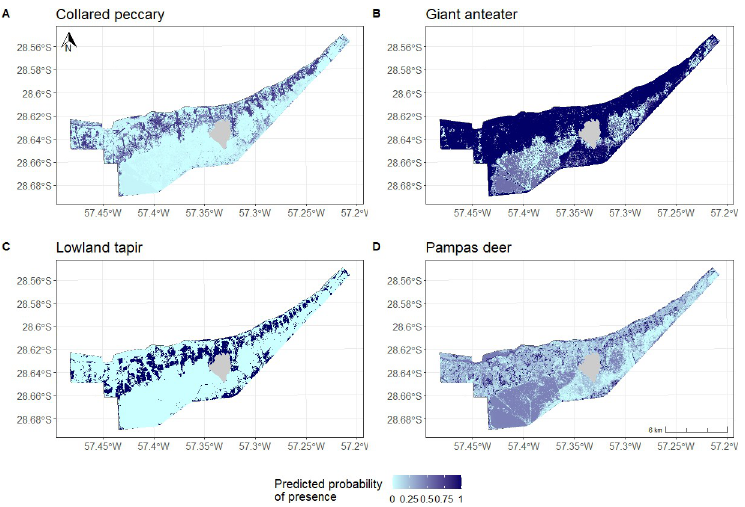
Fig 3. Habitat selection of reintroduced species (predicted probability of presence). Maps of predicted probability of presence for the four reintroduced species, giant anteater, pampas deer, lowland tapir and collared peccary, with a gradient from 1 (highest probability of presence) to 0 (lowest probability of